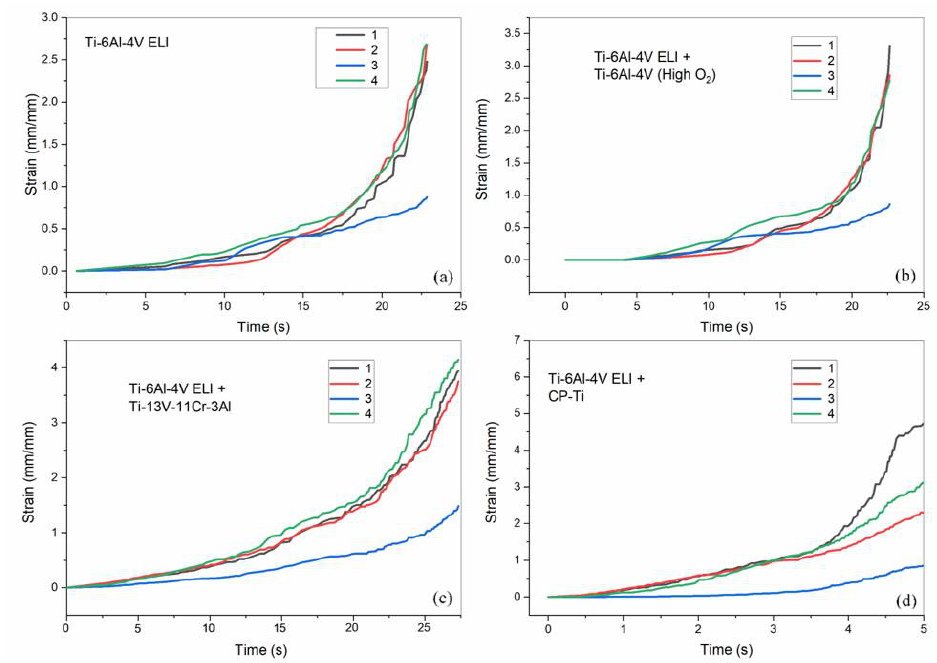
Figure 11. Strain at the four different points ( a ) Part 1, ( b ) Part 2, ( c ) Part 3, and ( d ) Part 4. The velocity of P3 was almost maintained as constant in all cases shown in Figure 10a,d because P3 was not directly in contact with the upper die during the process. Due to the stability of the material at the higher temperature, the peak velocity reached 4 mm/s by point P4, as shown in Figure 10a,d. Due to the higher thermal expansion of the shell material, peak velocity reached 15 mm/s and 12 mm/s, as shown in Figure 11a and 11b, respectively. Strain produced in all cases is similarly shown in Figure 11a,d, due to free deformation P3 producing less strain compared to other points (P1, P2, and P4). The re- maining points (P1, P2, and P4) produced similar strain values.